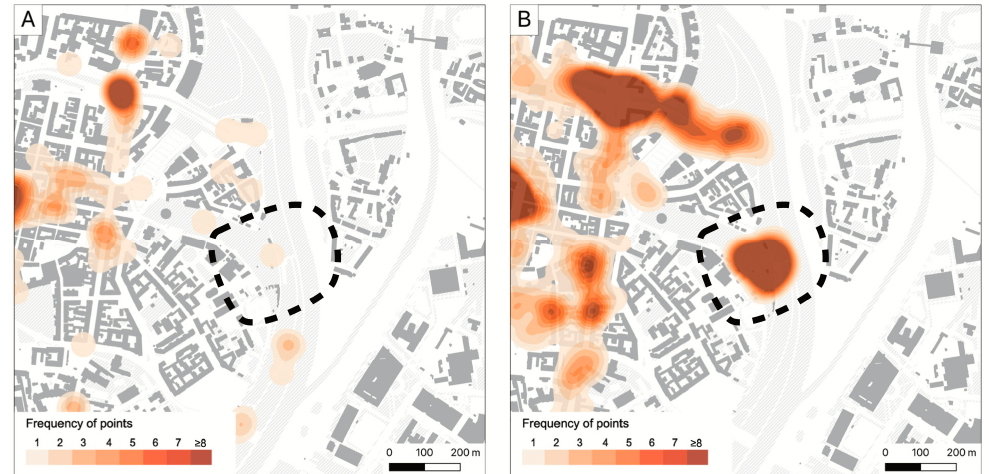
Figure 9. Comparison of places indicated by the group of residents ( A ) and urban planners ( B ) regarding noisy areas—cultural and recreational zone by the Warta River. The dashed black line marks the areas of difference. Source of reference data: © OpenStreetMap contributors, see: https://www.openstreetmap.org/copyright (accessed 10 February 2023).